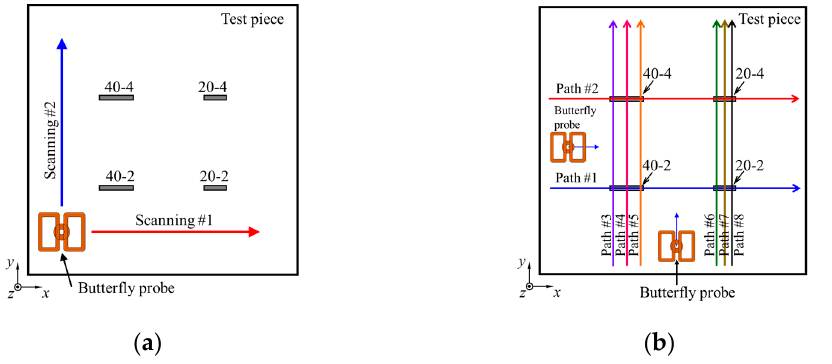
Figure 10. Scanning areas and paths on test piece: ( a ) scanning areas direction ( b ) scanning paths direction.